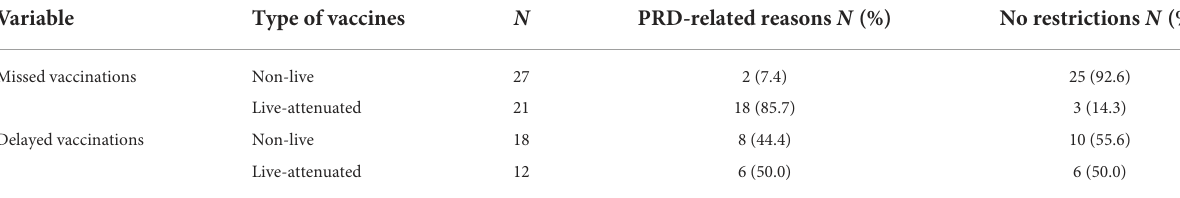
TABLE 3 Missed and delayed vaccinations and PRD-related restrictions.